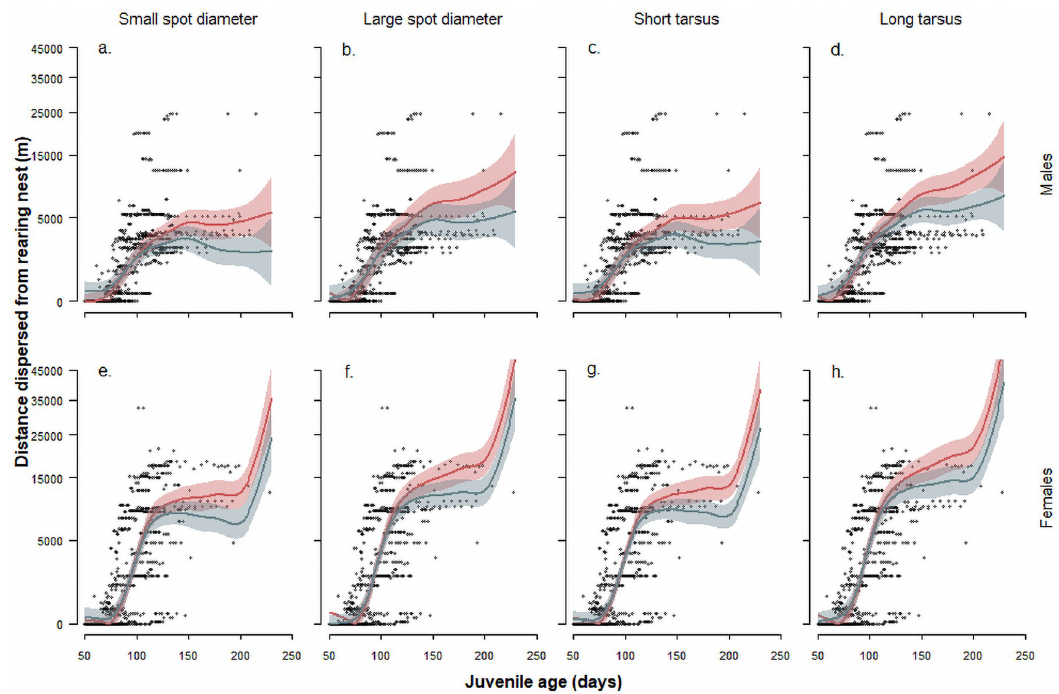
Fig 5. Distance (with 95% CrI) between the nest of rearing and diurnal roost site in relation to age, treatment (placebo (blue) vs. corticosterone (red)), sex (males: panels a-d; females: panels e-h), spot diameter (small diameter: panels a, e; large diameter: panels b, f) and tarsus length (small: panels c, g; long: panels d, h) in juvenile barn owls. Lines represent the group specific means with 95% CrI (shaded areas) based on the GAMM in Table 2. Black dots represent raw data.